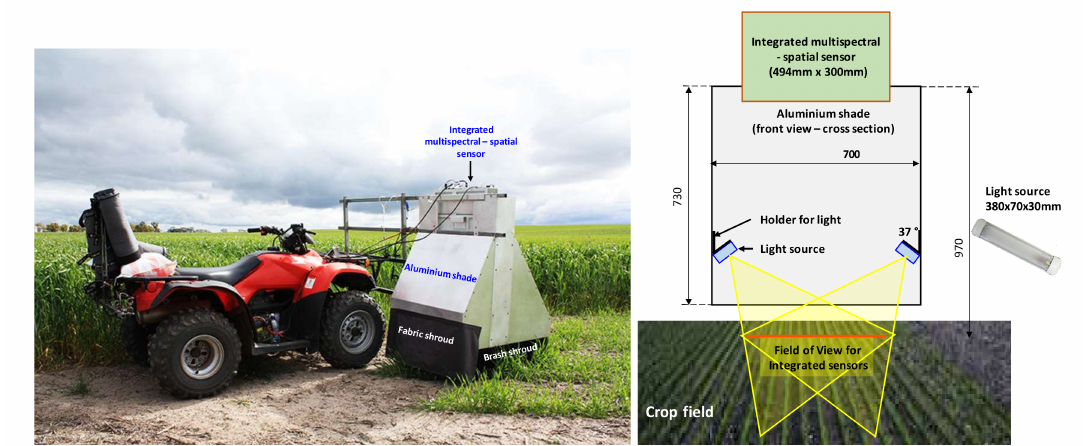
Figure 5. An integrated weed sensing system to collect plant images in the field.